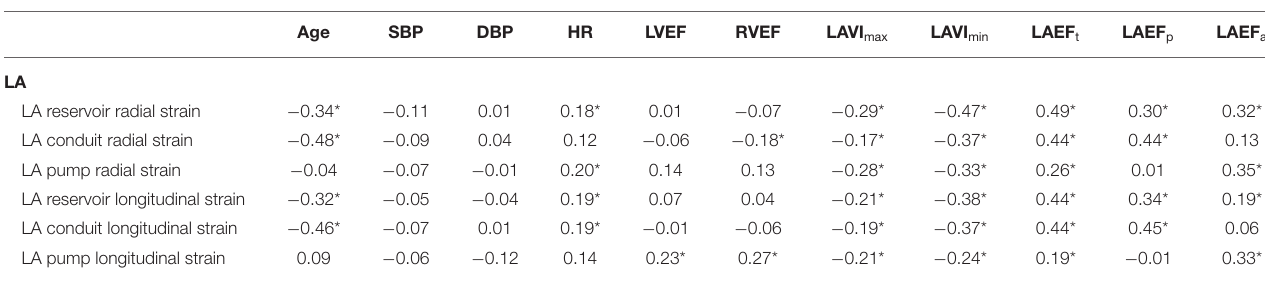
TABLE 3 | Correlation between left atrial strains and baseline